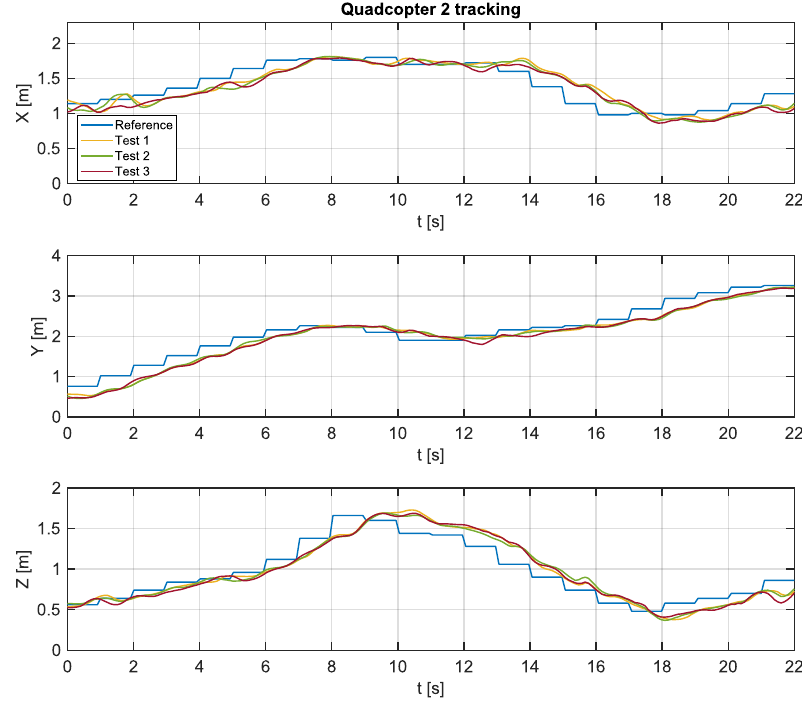
Figure 9. Path tracking of UAV 2.